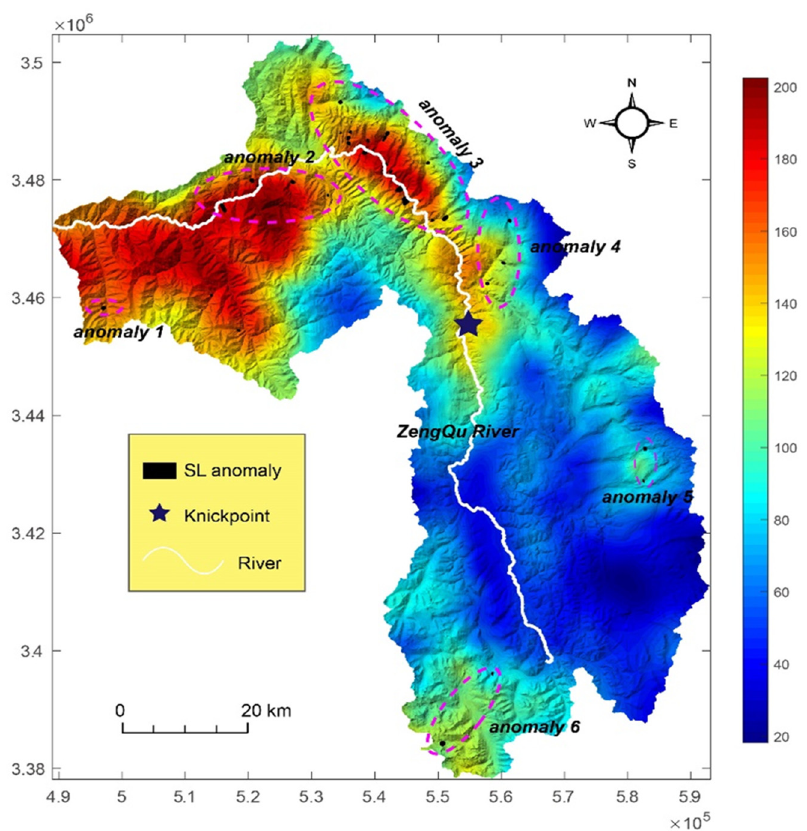
Figure 6. SL index anomalies and the spatial distribution of Ksn. The ellipses with magenta dashed line is significant SL index anomalous.